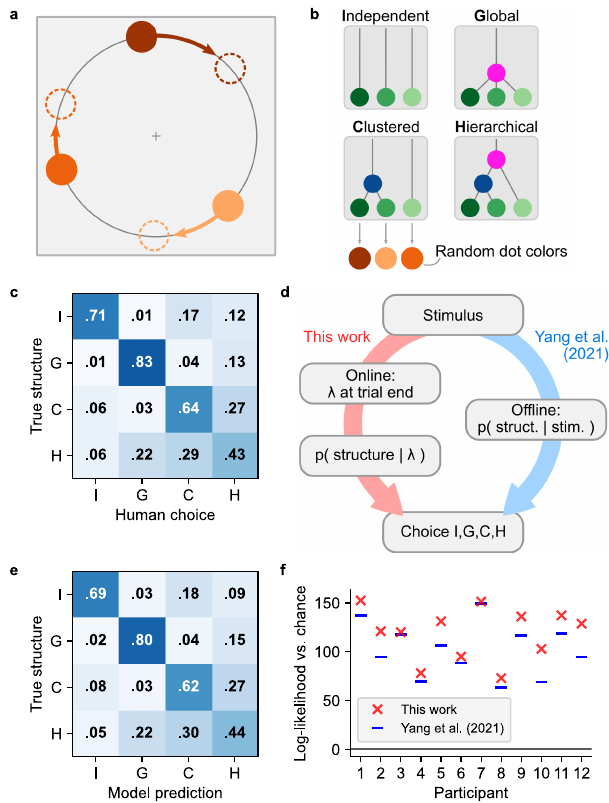
Fig. 3 | The model quantitatively explains human perception of nested and ambiguous motion scenes. a Stochastic motion stimulus from Yang et al. 17 con- sisting of three dots rotating on a circle. b Each trial followed one of four motion structures.Ifclusteredmotionwaspresent(CorHstructure),anypairofdotscould form the cluster. c Confusion matrix of human responses, averaged over all 12 participants. d Models for predicting human responses. Yang et al. employed a Bayesian ideal observer as the basis for fi tting a participant-speci fi c choice model. Ourmodel,incontrast,calculatesthelikelihoodforeachstructurefromthemotion strengths, λ t , at trial end and then fi ts the same choice model as Yang et al. for translating probabilities into human responses. e Confusion matrix of our model. f Log-likelihood of humanresponses relative to chance level,for both models. The analyses in panels e and f are leave-one-out cross-validated to prevent over fi tting. Source data are provided as a Source Data fi